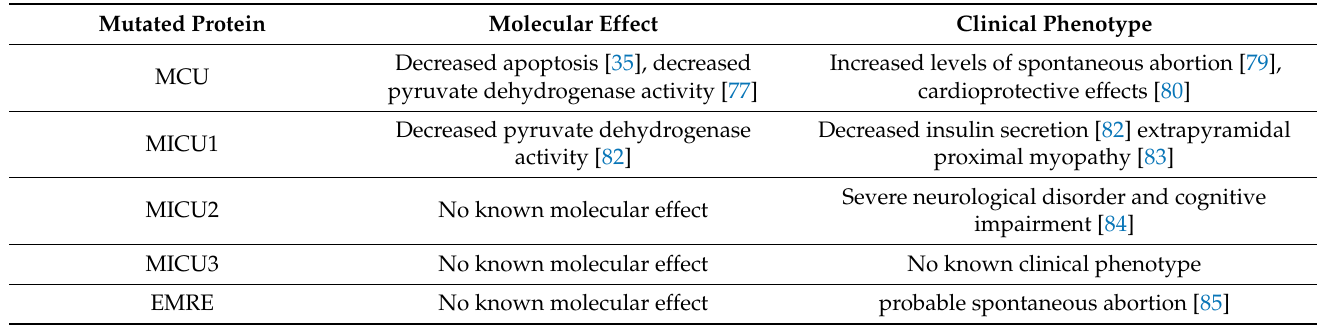
Table 2. Known MCU complex mutations with associated